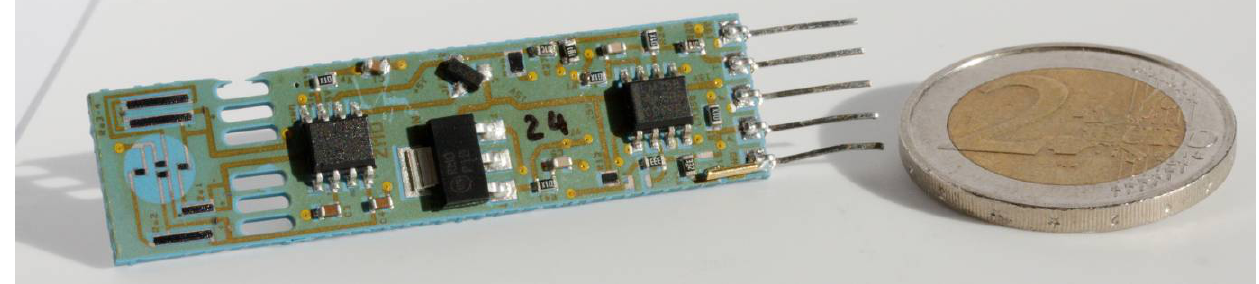
Figure 1. LTCC fluidic pressure-flow-temperature multisensor, with integrated signal conditioning electronics and solderable as an electro-fluidic SMD component on its bottom face (Figure 9). The five pins on the right are for test purposes